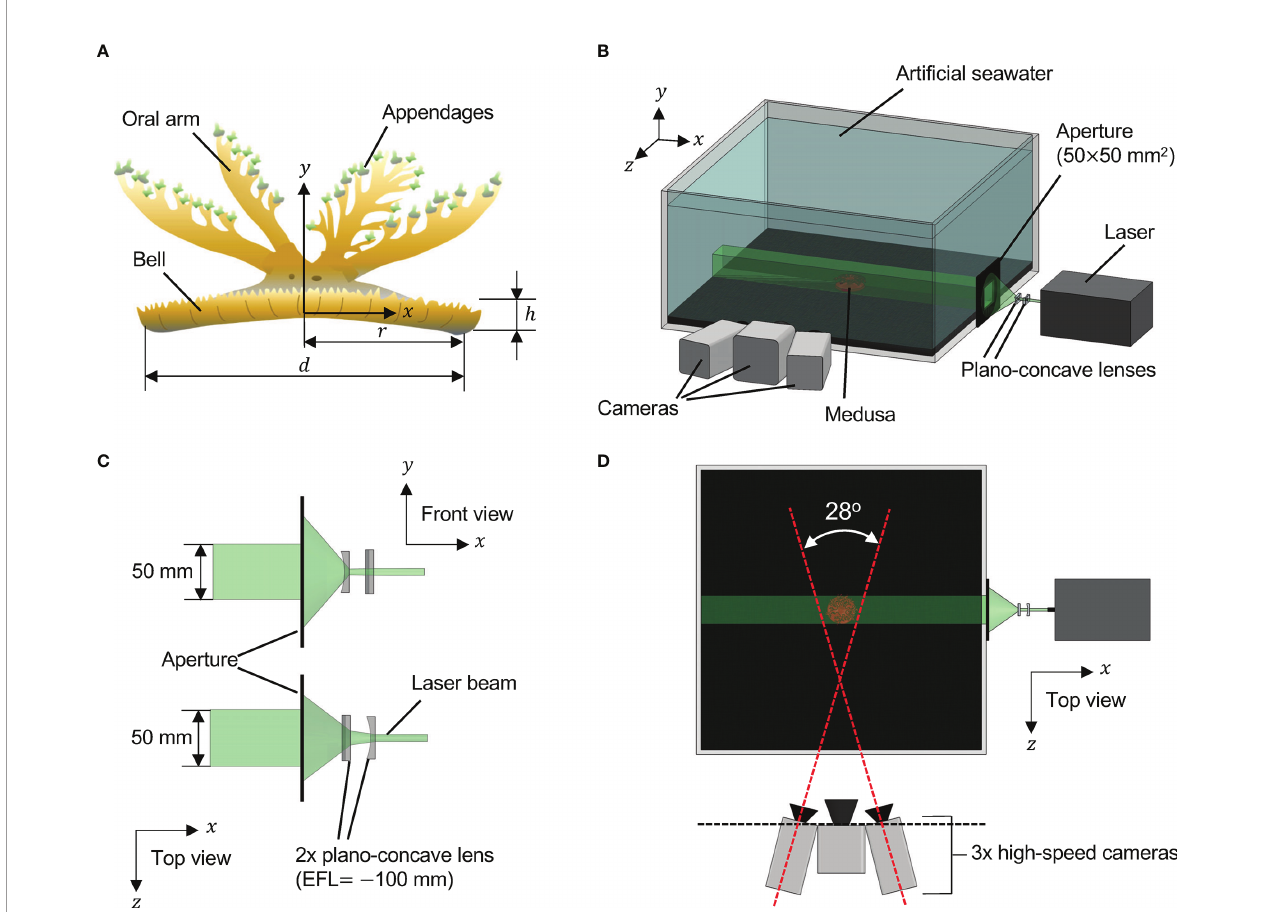
FIGURE 2 | Experimental arrangements. (A) Morphology of Cassiopea spp. with oral-aboral axis at ( x , z ) = (0,0). d = bell diameter; r = bell radius (= d /2); h = bell height. (B) Three-dimensional (3D) particle tracking velocimetry (PTV) setup. A medusa with oral arms removed ( d = 40 mm; h = 4 mm) was positioned centrally inside a 30 gallon test aquarium (0.609 m × 0.609 m in cross-section) containing arti fi cial seawater. Coordinate system used for experimental data analysis is shown. (C) Magni fi ed view of volume optics consisting of two plano-concave lenses oriented perpendicular to each other. Each lens had an effective focal length (EFL) of -100 mm. The laser illuminated volume was trimmed to a rectangular region using a custom-made aperture measuring 50 mm tall × 50 mm wide. (D) Top view of the 3D PTV setup showing the three high-speed cameras used for imaging, with two of the side cameras at 14° relative to x = 0